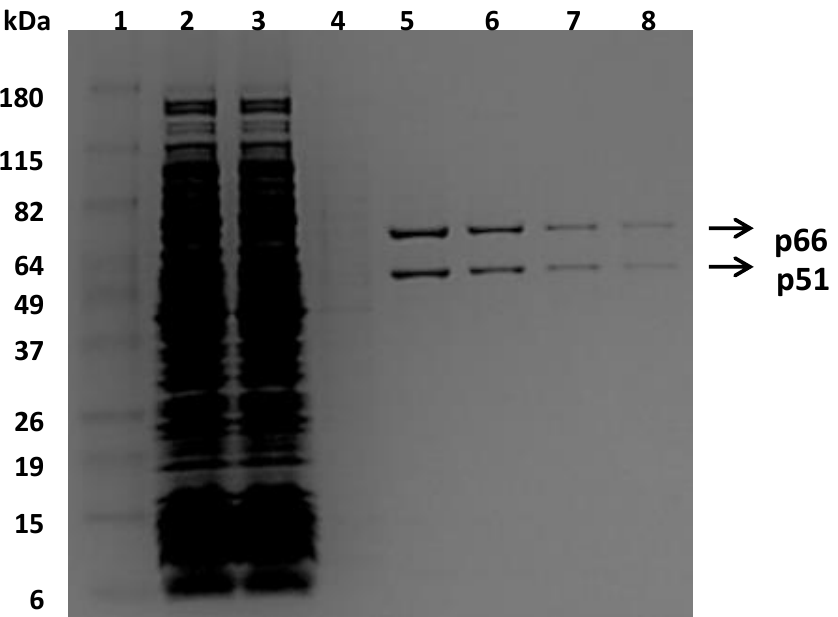
Figure 1. Sodium dodecyl sulfate polyacrylamide gel electrophoresis (SDS-PAGE) analysis of fractions collected from the purification of bio-reverse transcriptase (bio-RT) using the avidin affinity column. Lane 1, molecular weight marker; Lane 2, flow-through fraction; Lanes 3–4, washing fractions; Lanes 5–8, eluted fractions.